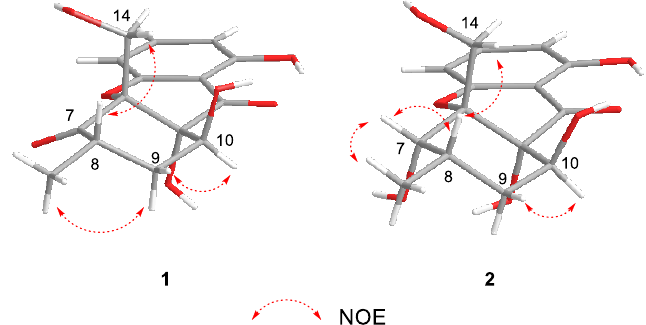
Figure 3. Key NOESY correlations of 1 and 2 .